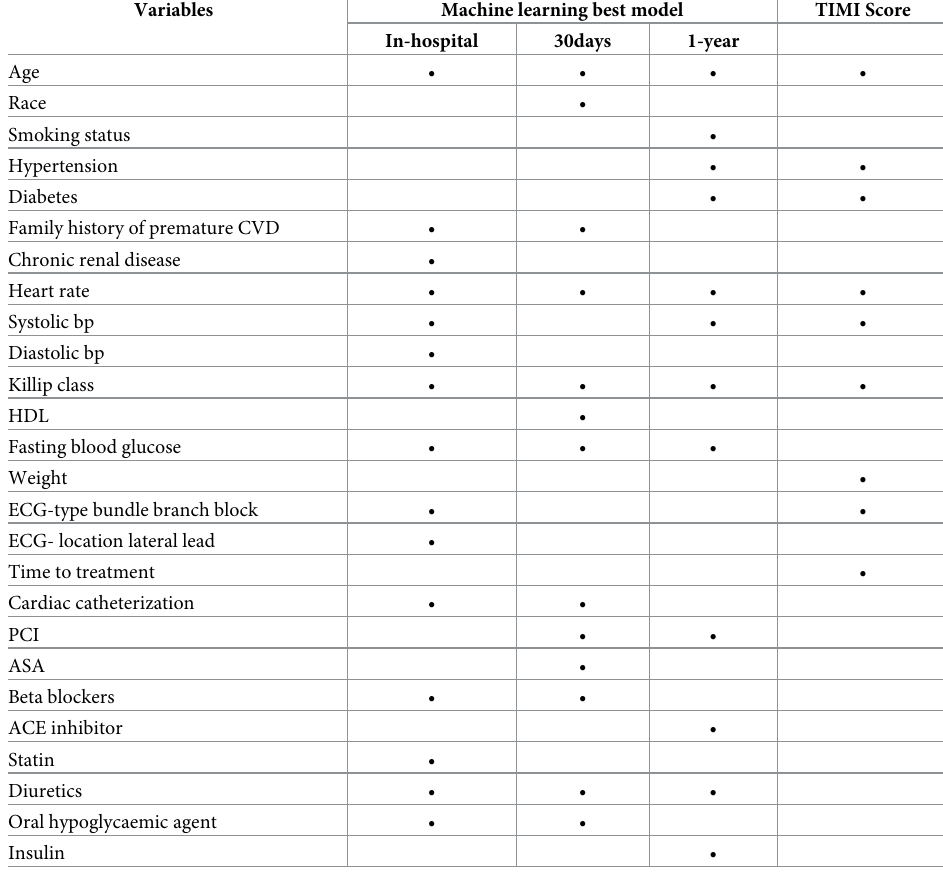
Table 4. Selected variables that resulted in optimum AUC for the best ML models (SVMvarImp-SBE-SVM) in in- hospital, 30-days, and 1-year against TIMI risk score